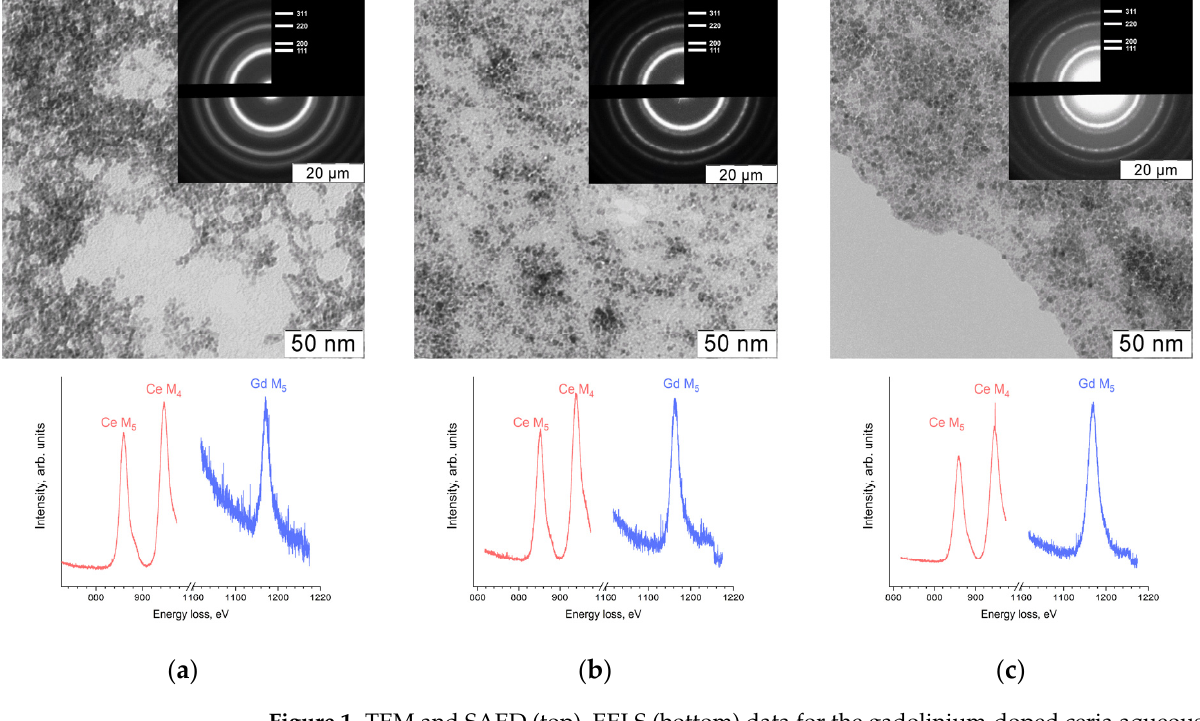
Figure 1. TEM and SAED (top), EELS (bottom) data for the gadolinium-doped ceria aqueous sols: ( a ) Sample 1; ( b ) Sample 2; ( c ) Sample 3.